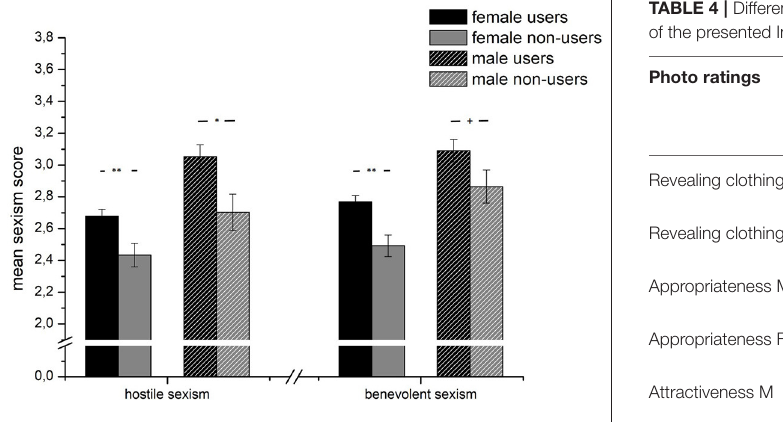
FIGURE 2 | Mean differences between Instagram users (black) and non-users (gray) separated by sex for hostile and benevolent sexism measured by the Ambivalent Sexism Inventory (ASI). + p < 0.1, * p < 0.05, ** p < 0.01.